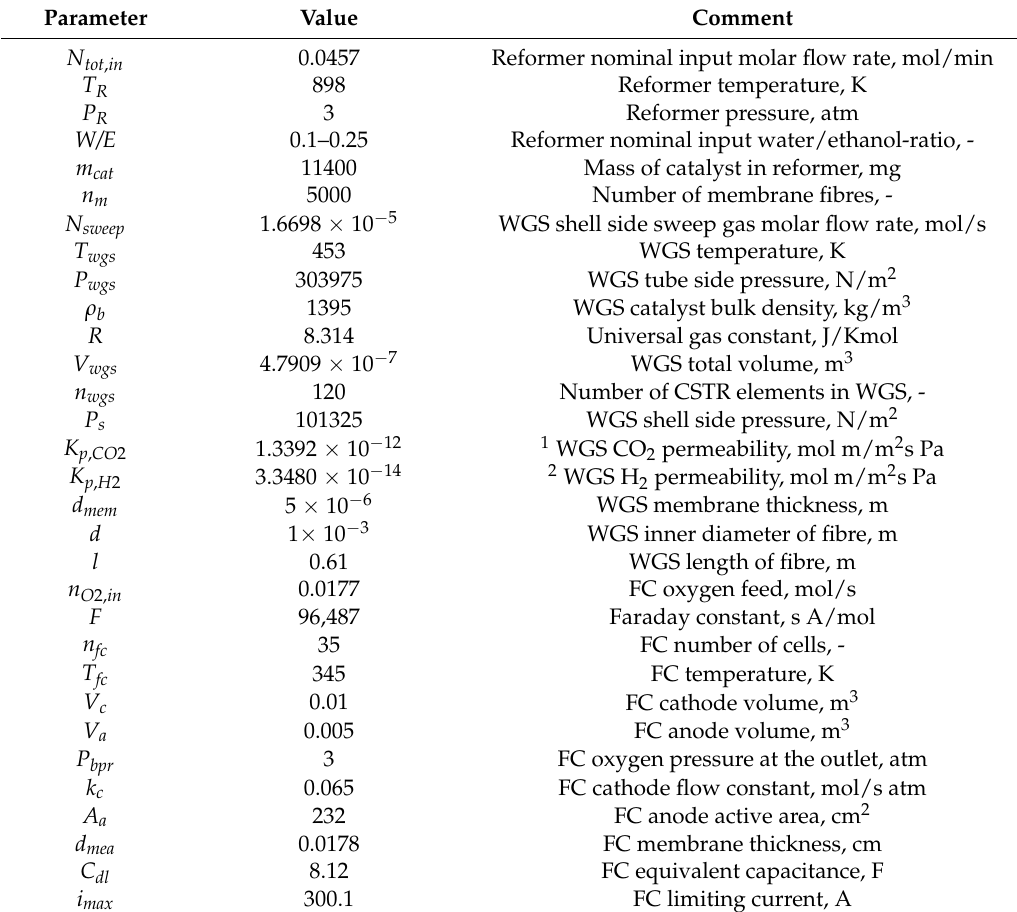
Table 2. Simulation